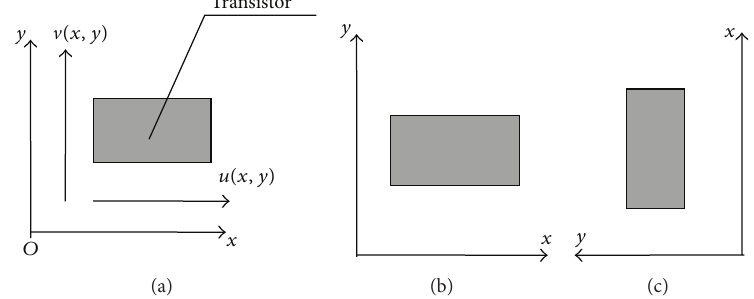
Figure 4: Displacements and positions of the transistor in the test: (a) displacements; (b) horizontal test; (c) vertical test.